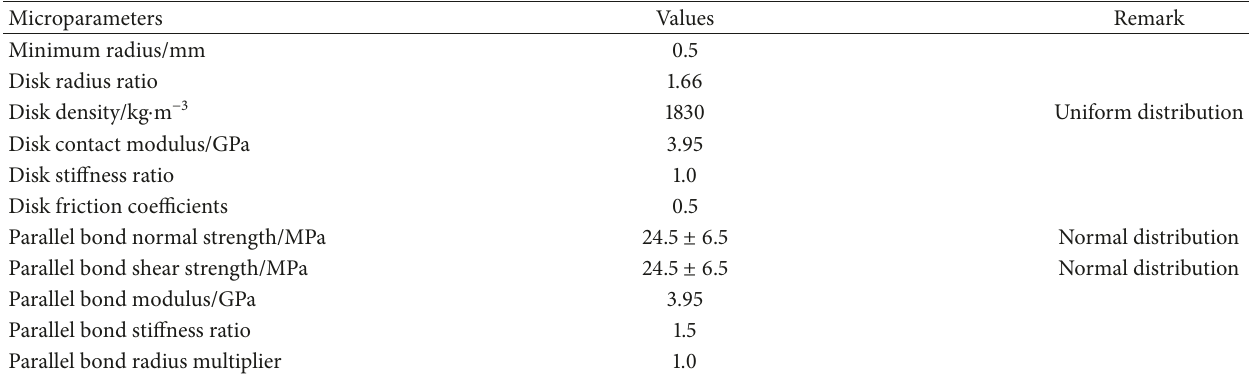
Table 1: Microparameters of the rock